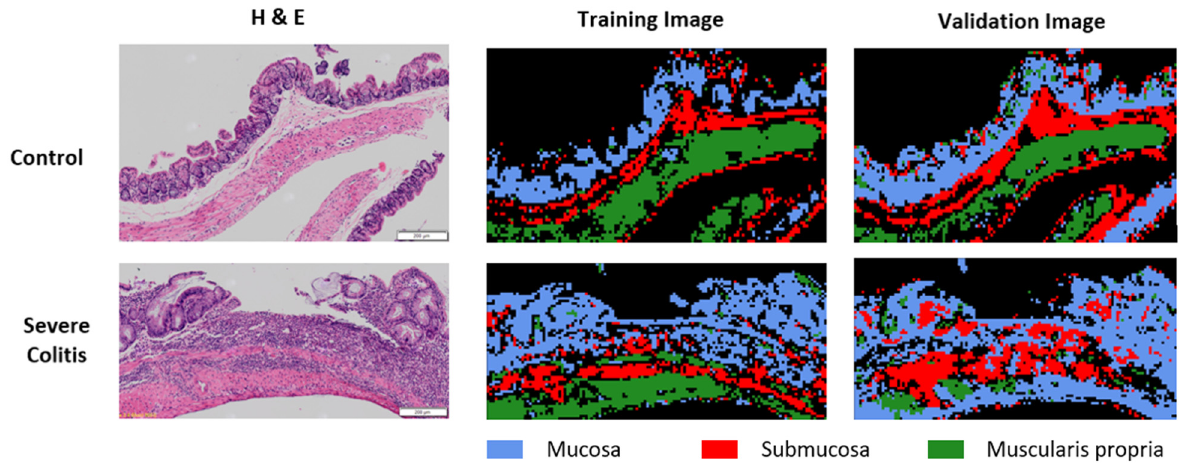
Figure 4. Hyperspectral image classification using ANN for controls and severe colitis. The training image depicts the classification performed on the entire original image using trained classes and the validation image uses trained classes from an independent sample.